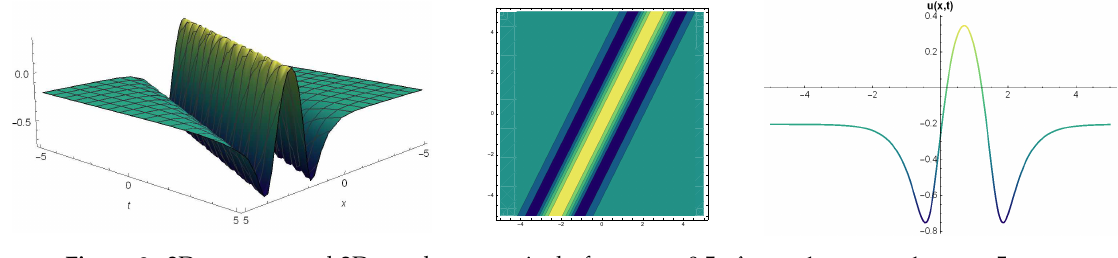
Figure 3. 3D, contour and 2D graphs respectively for p = − 0.5, λ = − 1, c 2 = − 1, c 1 = 5, q = − 1, w = 0.5 values of Equation